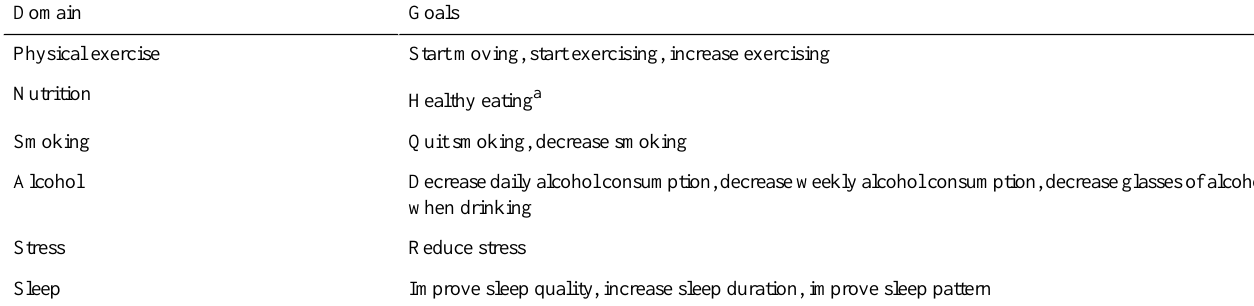
Table 1. Domains and